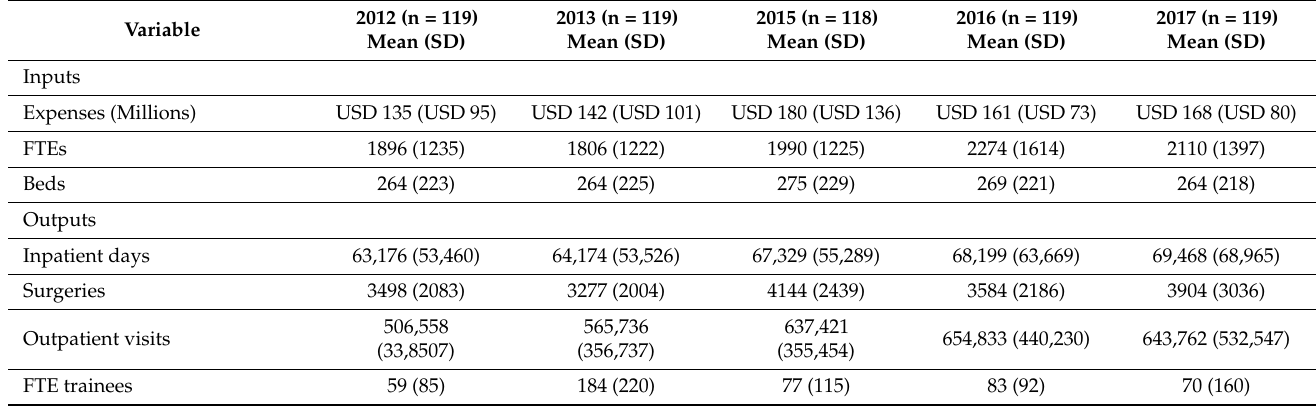
Table 1. Descriptive Statistics of Input and Output